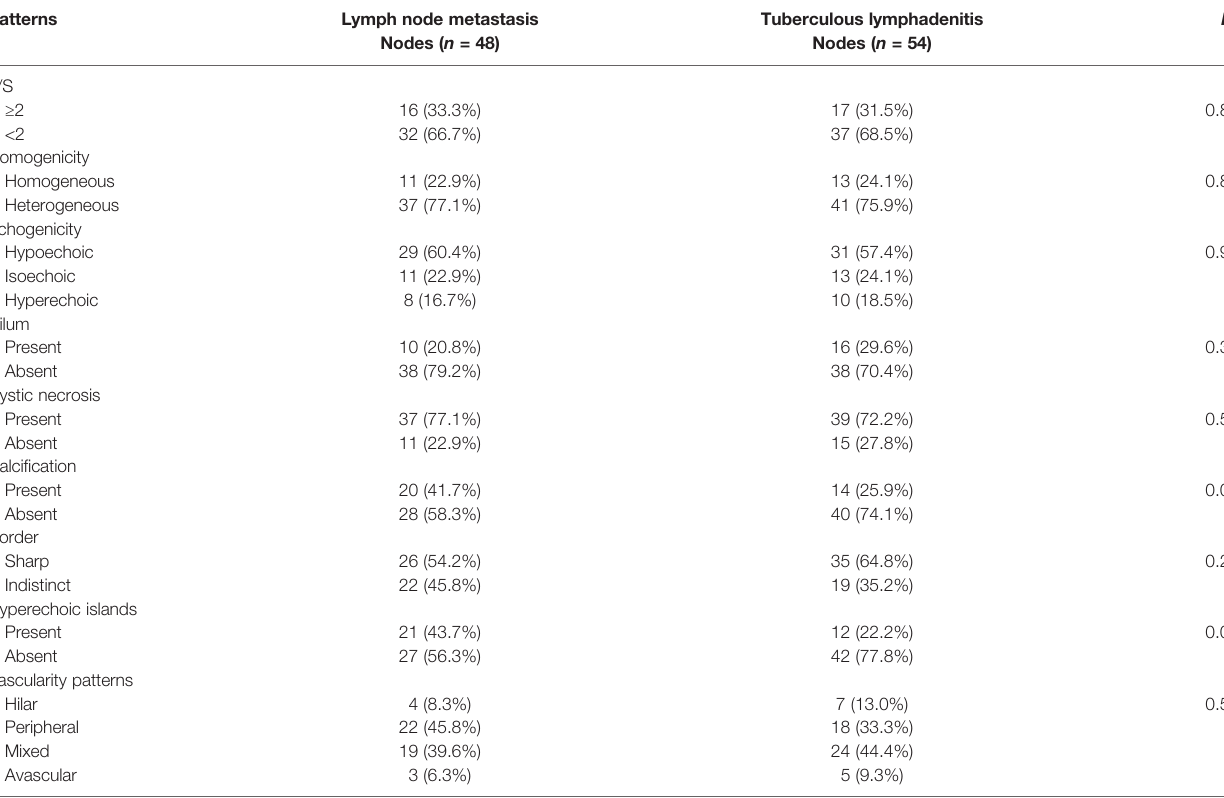
TABLE 1 | Comparison of ultrasonography features in tuberculous lymphadenitis and lymph node metastasis.